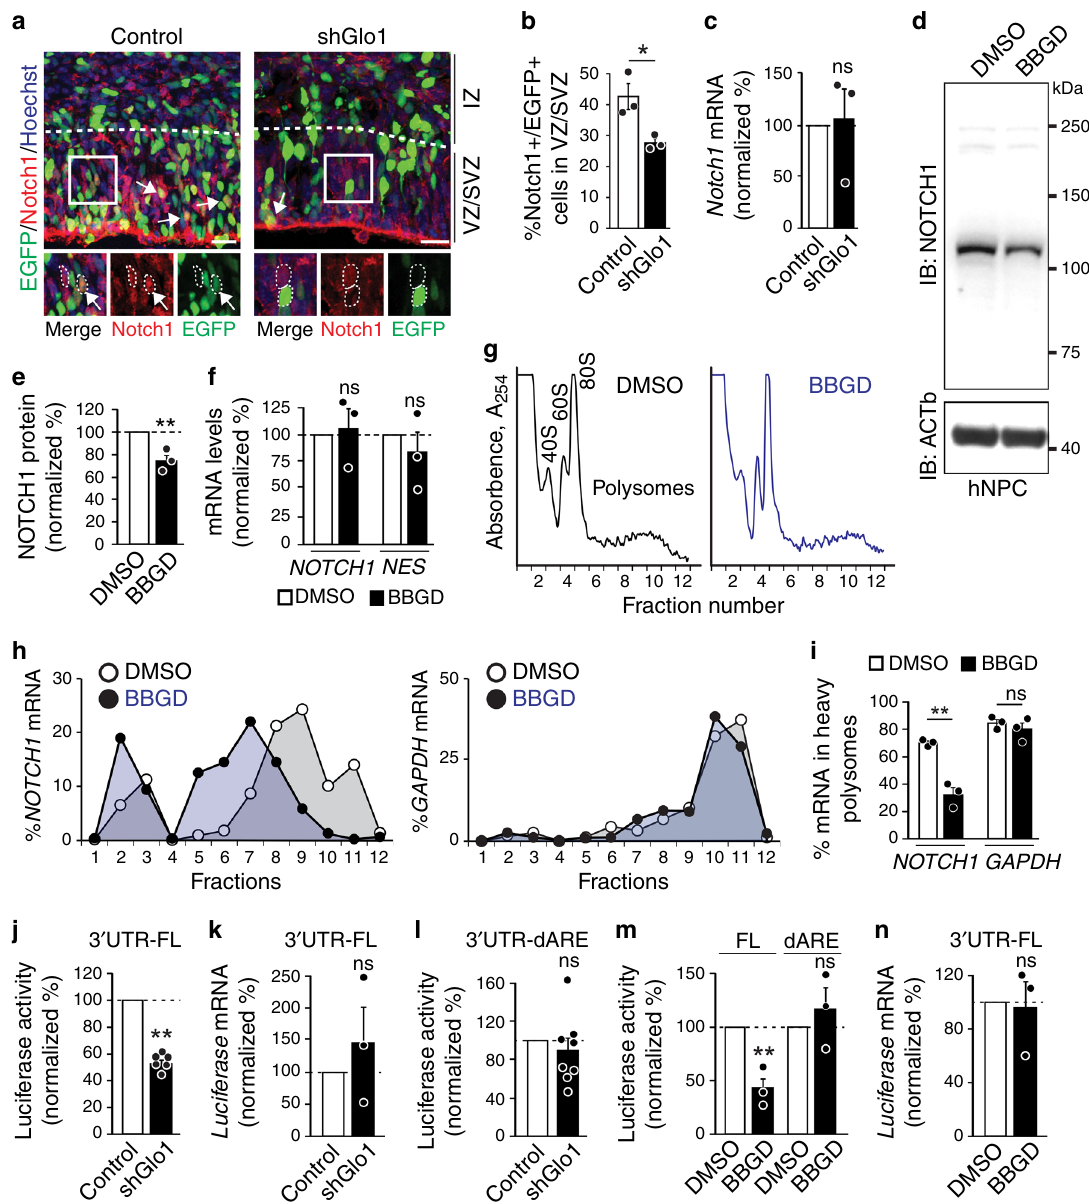
Fig. 3 Methylglyoxal suppresses Notch1 mRNA translation. a – c E13.5 cortices were co-electroporated with nuclear EGFP and control or Glo1 (shGlo1) shRNAs and analyzed two days later. Images ( a ) and quanti fi cation ( b ) of EGFP + cells (green) also positive for Notch1 (red). White boxes in a show higher magni fi cation at the bottom. Arrows denote double-labelled cells. n = 3 embryos each. c qRT-PCR analysis for Notch1 mRNA in FACS sorted EGFP + cells from cortices as in a . n = 3 embryos each. d – i hNPCs were treated with DMSO or BBGD for 48 h. Images ( d ) and quanti fi cation ( e ) from western blots of hNPCs probed for NOTCH1 and ACTb. n = 3 experiments. f qRT-PCR analysis for NOTCH1 and NESTIN ( NES ) mRNAs in hNPCs. n = 3 experiments. g Polysome pro fi le of hNPCs. Fractions corresponding to 40 S and 60 S ribosome subunits, the 80 S monosomes and polysomes are labelled. h Relative distribution of the NOTCH1 mRNA (left) and GAPDH mRNA (right) across all fractions measured by qRT-PCR. Each point corresponds to the value of each fraction normalized to the total NOTCH1 or GAPDH mRNA. i Quanti fi cation of the relative enrichment of NOTCH1 and GAPDH mRNAs in the heavy polysome fractions (#8 – 12). n = 3 experiments. j – l Dual-luciferase reporters containing the full-length (FL) or truncated Notch1 3 ʹ UTR (dARE) were co- electroporated into E13.5 cortices with control or Glo1 shRNAs. j Luciferase activity of the reporter. n = 6 embryos each. k Luciferase mRNA levels quanti fi ed by qRT-PCR. n = 3 embryos each. l Luciferase activity from the 3 ʹ UTR-dARE reporter. n = 8 embryos each. m , n hNPCs were transfected with dual-luciferase reporters and treated with DMSO or BBGD for 48 h. m Luciferase activity of the reporters.; n = 3 experiments. n Luciferase mRNA levels quanti fi ed by qRT-PCR. n = 3 experiments. Scale bars, 25 µ m. Data are presented as mean values ± SEM and analyzed using two-tailed, unpaired students t -test. ** p < 0.01, * p < 0.05, ns = p > 0.05. Source data and p-values are provided as a “ Source Data fi le ”